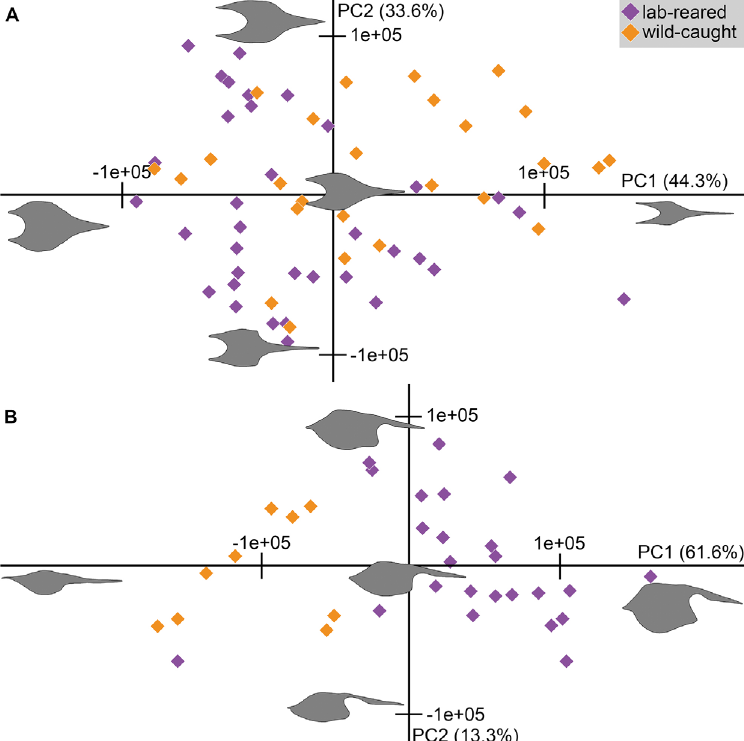
Figure 3. Plot of principal components from the PCA on the SHAPE analysis of shield outlines of Galatheidae. A : PC1 plotted against PC2, both from the dorsal analysis. Shapes included are from graphical component loadings and depict the mean shape of the principal component and +/-2 standard deviations of the mean shape. B : PC1 plotted against PC2, both from the lateral analysis.